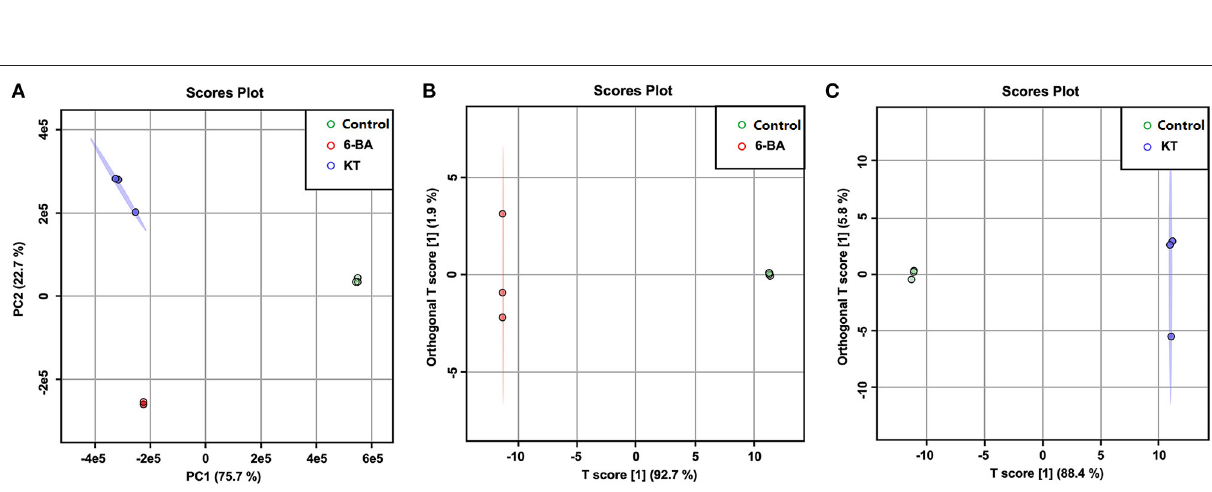
be significantly different based on a VIP > 1 and P -value < 0.05, and the results are shown in Supplementary Table 2